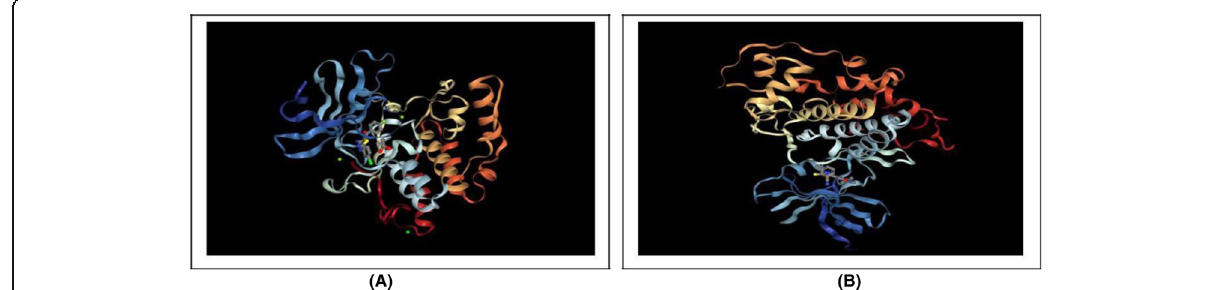
Fig. 4 Three dimension structure of ( A ) casein kinase-1 (PDB Id: 2IZS) and ( B ) glycogen synthase kinase-3 β (PDB Id: 3F88) in their native ligand- bound form. Receptors are represented in cartoon style and ligands are represented in ball and stick